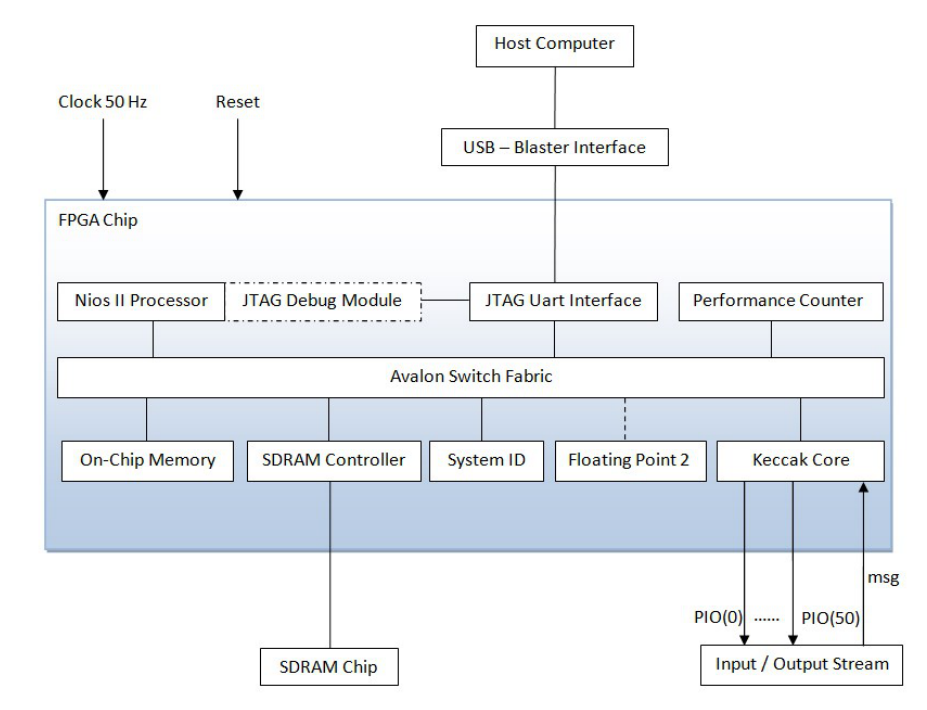
Figure 7. The block diagram of the entire system. Nios II system implemented on the DE5a-NET DDR4